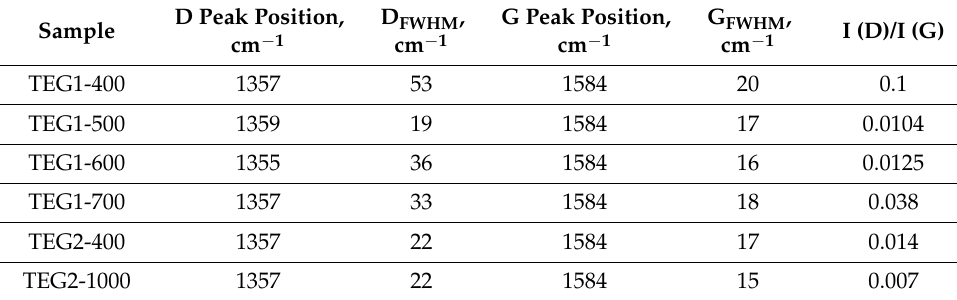
Table 4. Raman spectroscopy data of EG